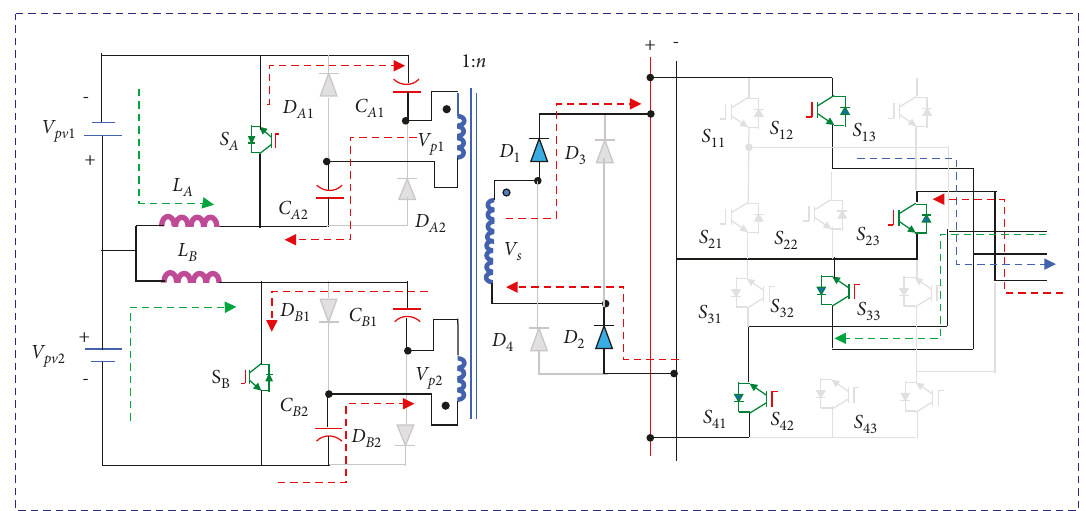
Figure 9: Equivalent circuit of mode 5 operation.